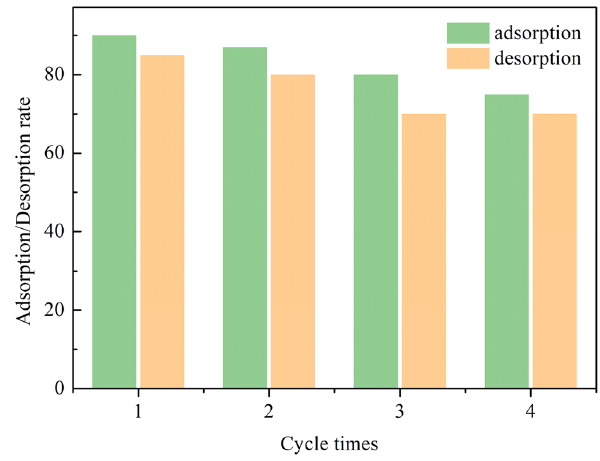
Figure 14: Regeneration and reusability of Ni ( II )- IIP 5